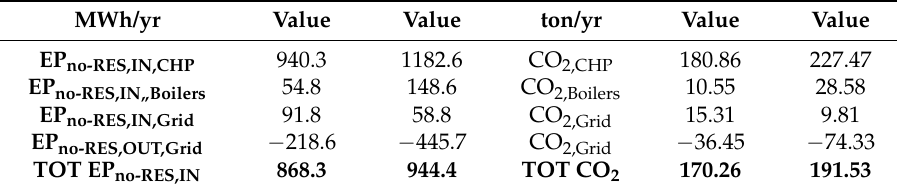
Figure 8. Electrical energy balance (MWh/yr). Table 6. Energy and environmental performance indexes.